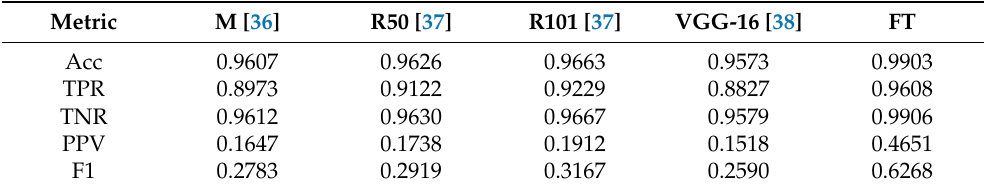
Table 2. Performance comparison on SIXray. The drastic decrease in the F1-score as compared to the accuracy is a reflection of the imbalance of the dataset.